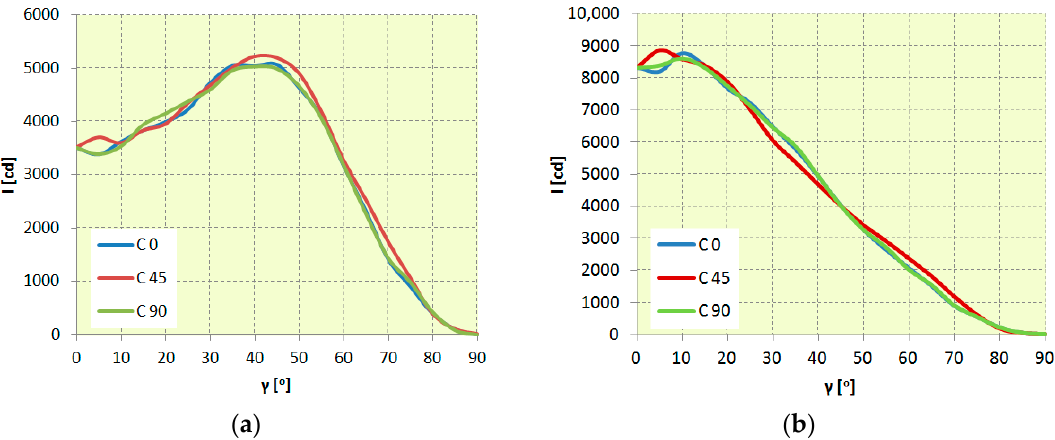
Figure 15. Luminous intensity curves for a luminaire with a diffuse reflector: ( a ) wide distribution ( b ) narrow distribution.